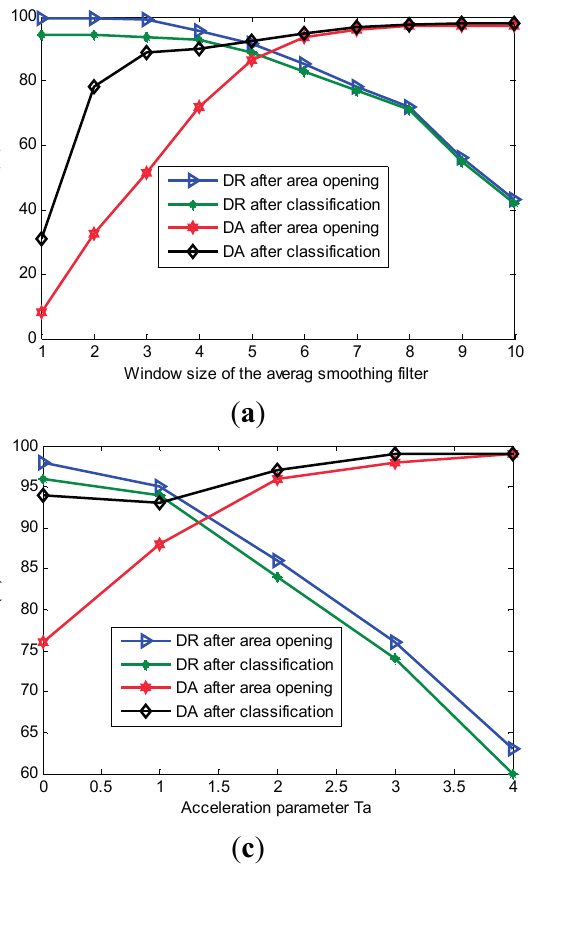
Figure 10. Detection rates and accuracies with different parameters: ( a ) window size of the average smoothing filter; ( b ) size of the structure element; ( c ) acceleration parameter; ( d ) pixel number threshold of area